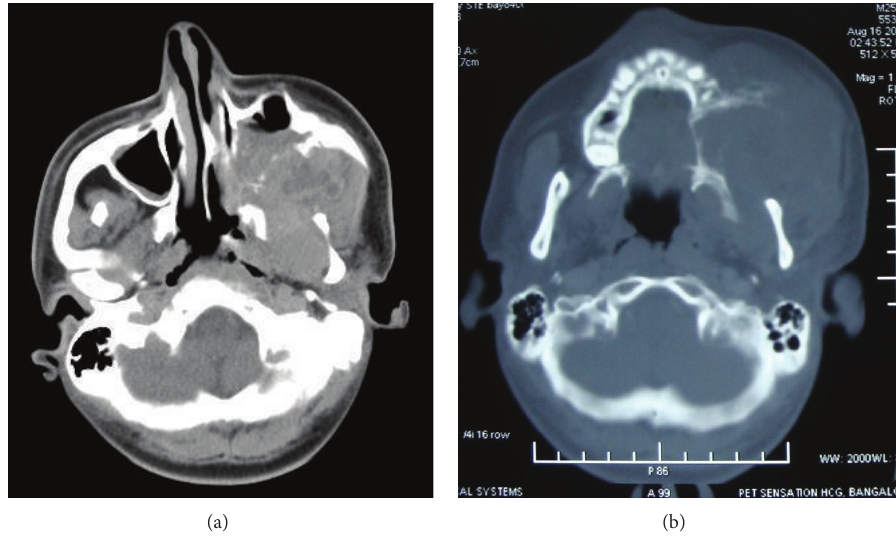
Figure 6: CT showing the extent of the lesion.